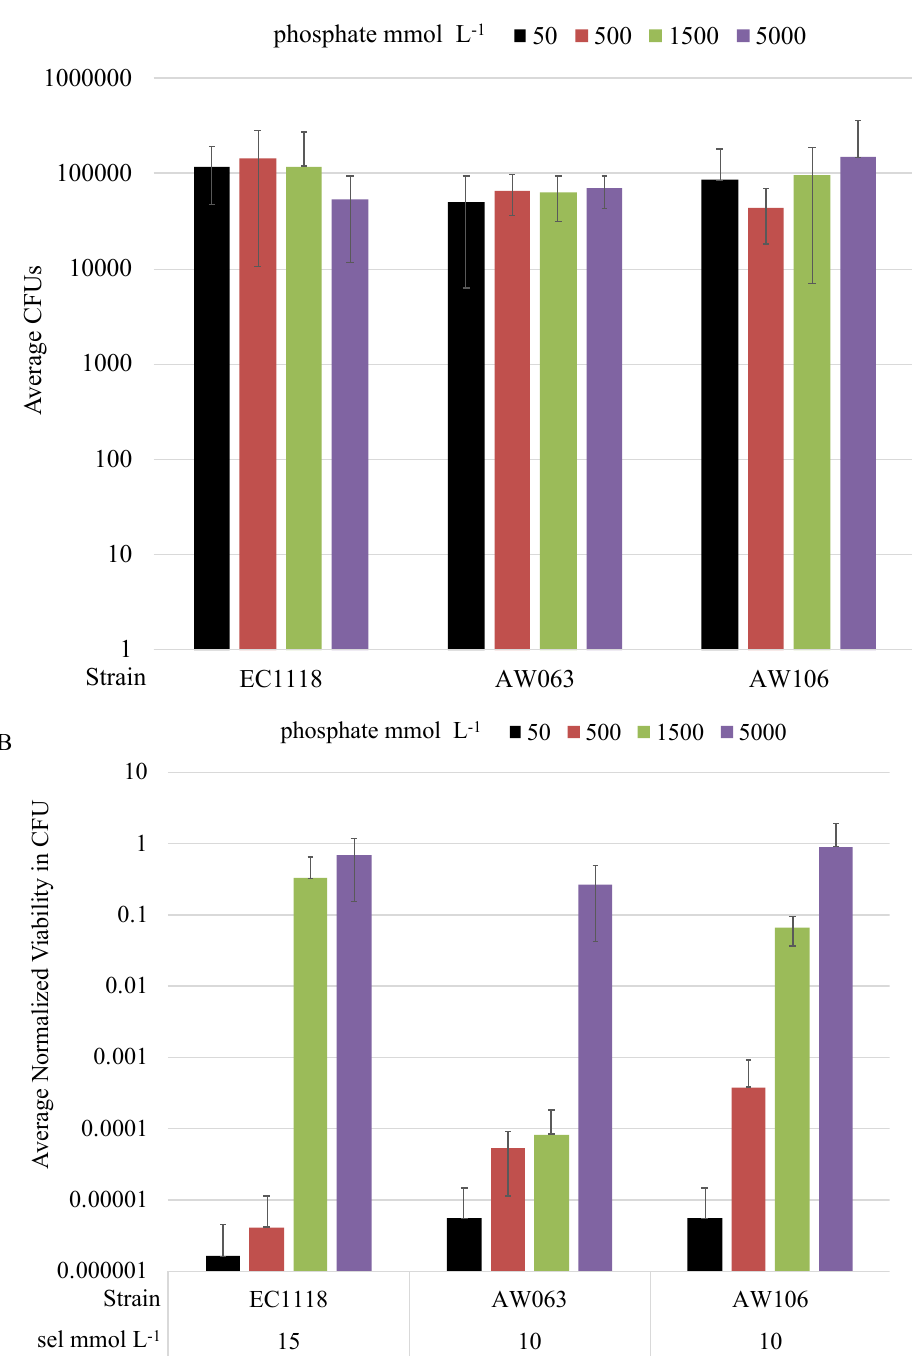
Figure 4. Colony forming ability of yeast strains in phosphate-limited medium with selenite. Strains were grown overnight in medium lacking phosphate, then tadpoled into medium containing the indicated amount of phosphate without selenite ( A ) or with sodium selenite ( B ). The concentration of sodium selenite added varied by strain, with EC1118, AW063, and AW106 receiving 15, 10, and 10 mmol L −1 sodium selenite respectively. Cultures grew for up to seven days, then colonies were counted (CFUs). The number of colonies formed in medium containing selenite was divided by the number of colonies formed in medium lacking selenite to calculate the Normalized Viability in CFU. These results were averaged over three experiments. Results shown on a logarithmic scale .